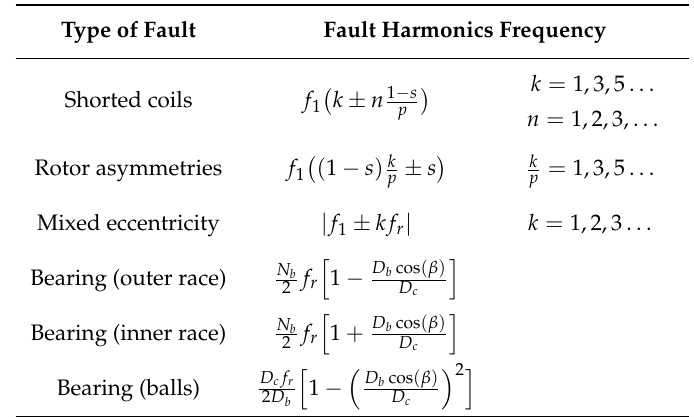
Table 1. Characteristic Frequencies of Different Types of Induction Machine (IM)